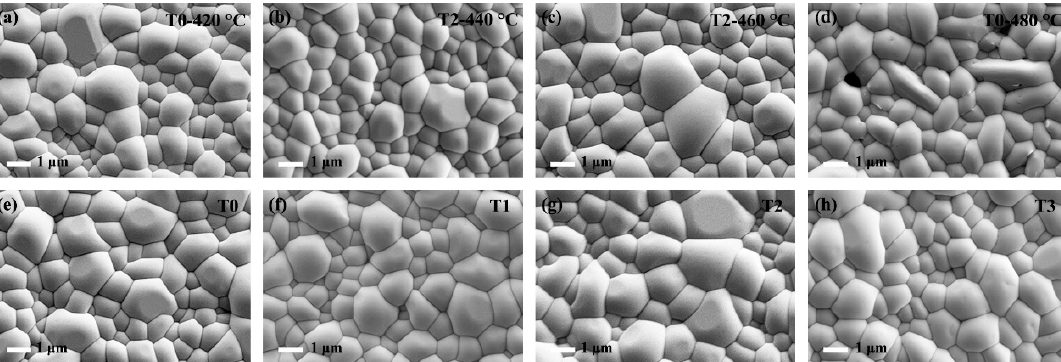
Figure 2. Surface morphology image of the pure Sb 2 Se 3 and Te-Sb 2 Se 3 thin films under different selenization temperatures, denoted as ( a ) T0-420 °C, ( b ) T2-440 °C, ( c ) T2-460 °C, and ( d ) T2-480 °C, respectively. Top-view SEM picture of the pristine Sb 2 Se 3 and Te-Sb 2 Se 3 thin films under the different weights of the Te source, labeled as ( e ) T0, ( f ) T1, ( g ) T2, and ( h ) T3, respectively.